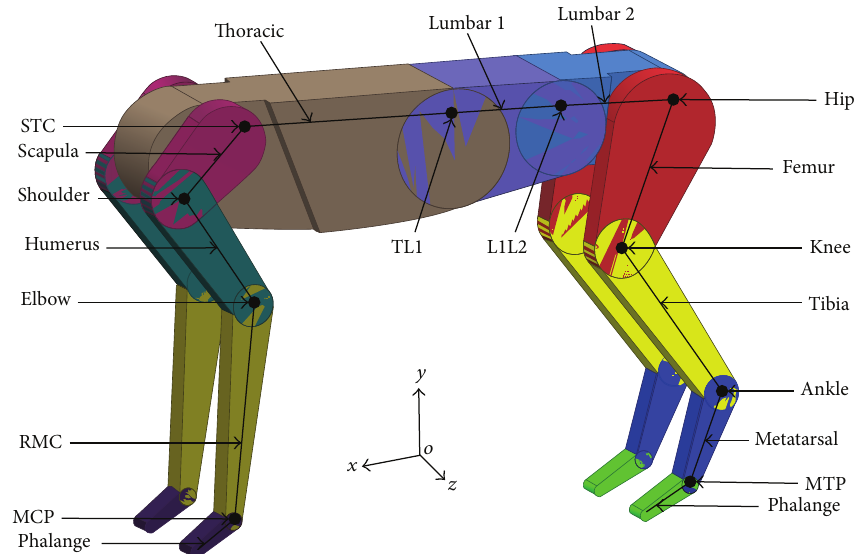
Figure 1: Dynamic model of